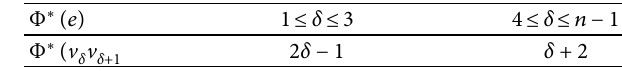
Table 2: Edge labeling of Φ ∗ ( e ) .